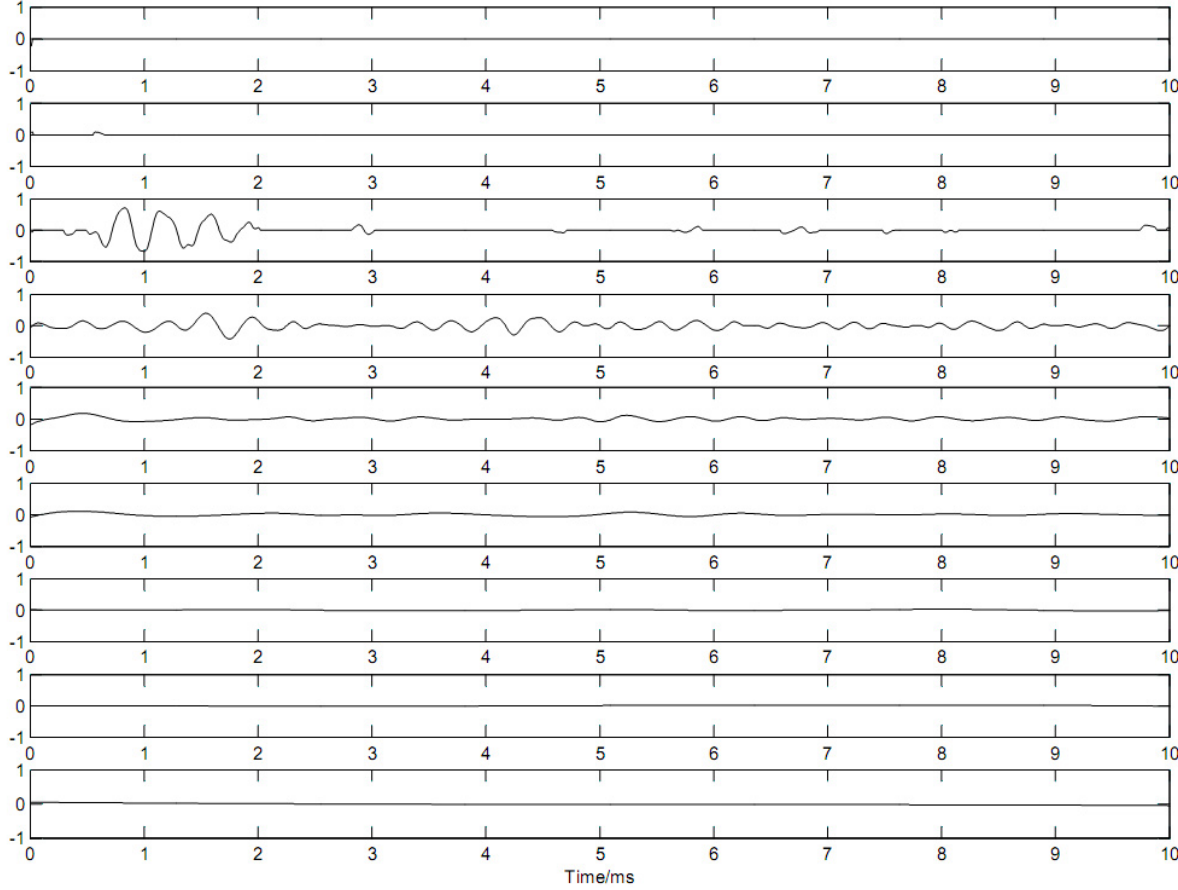
Figure 6. Results obtained by the threshold operation according to IHP.